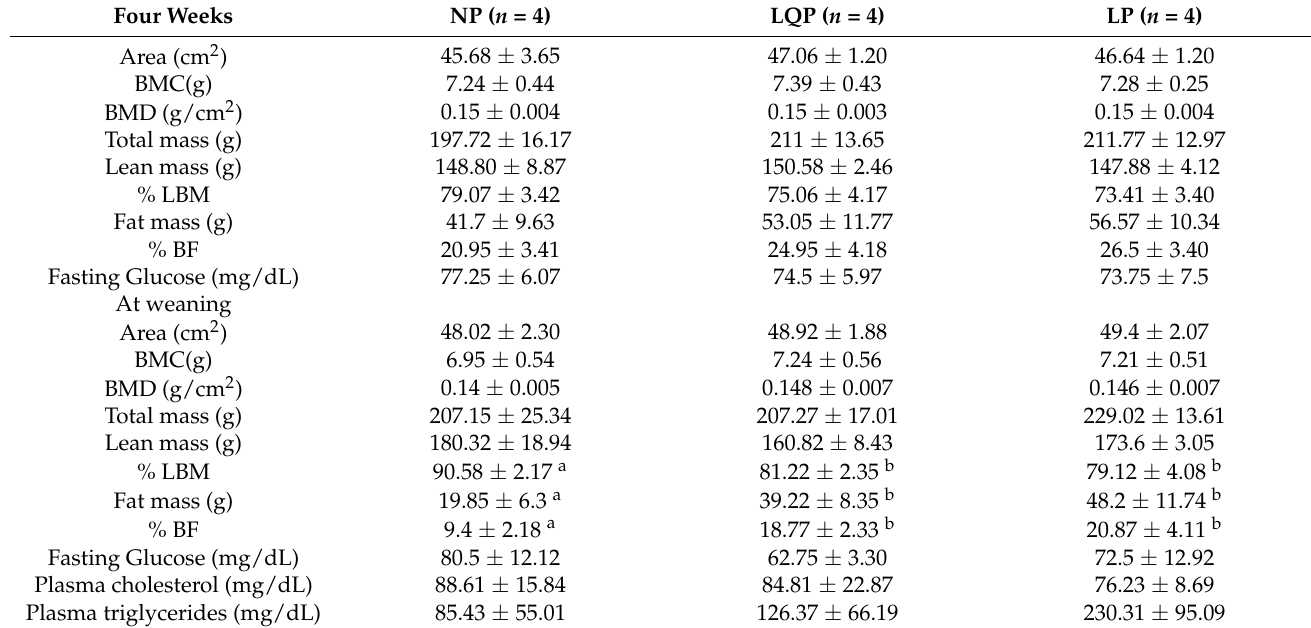
Table 2. Effect of quality and quantity protein restriction on the whole-body composition and metabolic factors in